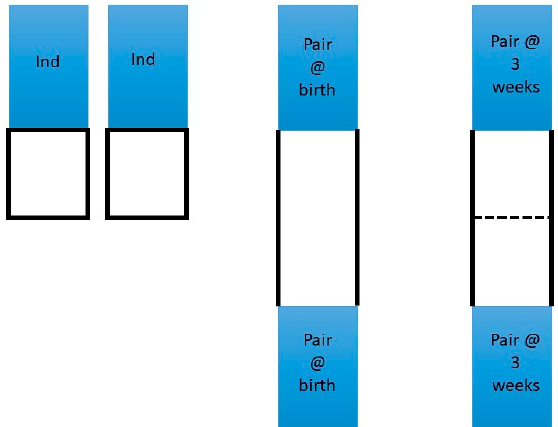
Figure 1. Diagram demonstrating the layout of the three different housing groups in the study. ‘Ind’ identifies the hutches for individual calves. The blue boxes indicate the calf hutch, the black solid lines indicate the metal partitions surrounding the outside area of the pen, and the black dashed line indicates the small internal gate used to initially separate calves that became pair housed at three weeks of age. The individual pens were placed next to each other so calves could only see each other when outside.